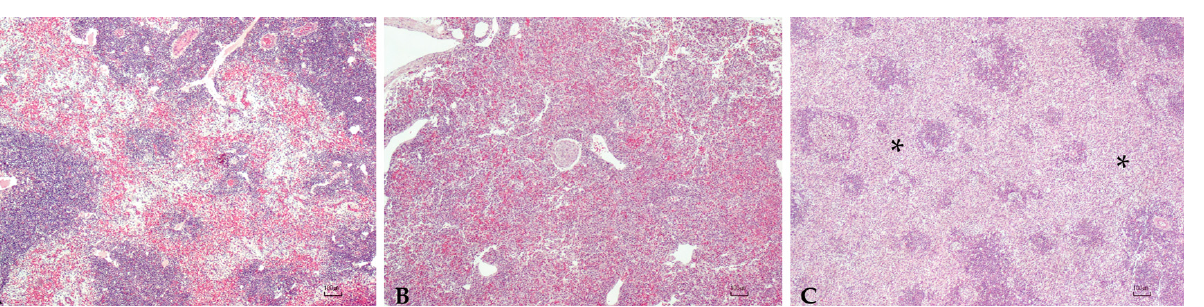
Figure 1. Liver : Mild ( A ), moderate ( B ), and severe ( C ) granulomatous chronic hepatitis cantered around the bile ducts and arterial vessels (asterisk, ( B )). Granulomas consisted of a high number of macrophages, a moderate number of lymphocytes and plasma cells, scattered eosinophilic granular cells (inset ( B )), and occasionally 80–100 µ m, round, multinucleated cells with round peripherally- located nuclei with dispersed chromatin and granular eosinophilic cytoplasm (Langhans-type cells) (arrow, inset ( C )). H.E. Bar ( A – C ) = 100 µ m, inset 10 µ m.